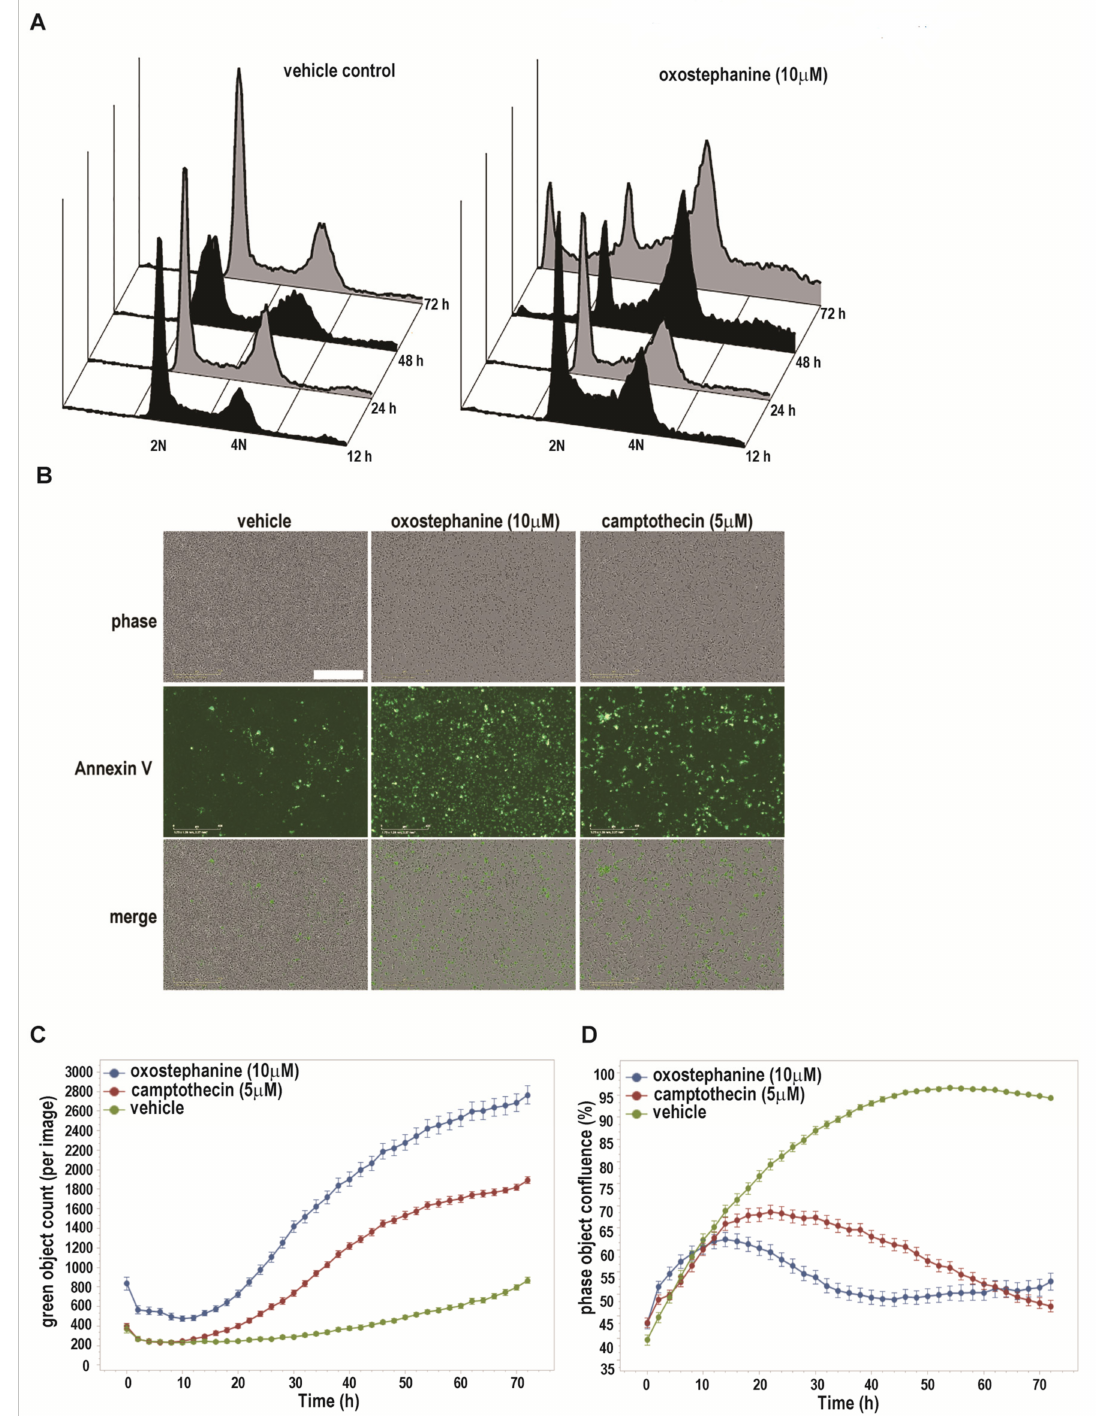
Figure 3. Oxostephanine ( 1 ) causes G2 / M arrest and apoptosis. ( A ) Asynchronous HeLa cells were treated with 10 µ M oxostephanine 1 or sham control for 12–72 h, and analysed their cell cycle distributions by flow cytometry. ( B , C ) MDA-MB-231 cells treated with oxostephanine undergo apoptosis by 48 h. Representative images of cells at 48 h post-oxostephanine are shown. Bar = 100 µ m. Quantification of Annexin V positive cells over the 72 h time course are shown in ( C ). Error bars = SEM, n = 4. ( D ) Quantification of cell population indicates that oxostephanine inhibits proliferation of MDA-MB-231 cells within 12 h of treatment. Error bars = SEM, n =